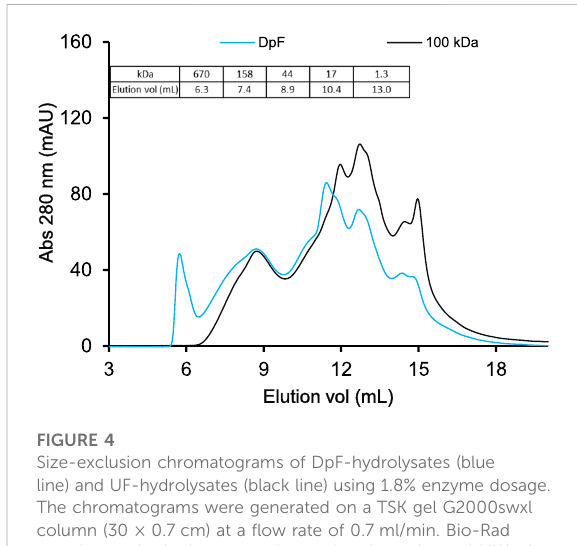
FIGURE 4 Size-exclusion chromatograms of DpF-hydrolysates (blue line) and UF-hydrolysates (black line) using 1.8% enzyme dosage. The chromatograms were generated on a TSK gel G2000swxl column (30 × 0.7 cm) at a fl ow rate of 0.7 ml/min. Bio-Rad protein standard mix was used to assign the estimated MW of hydrolysate peaks (table inset).